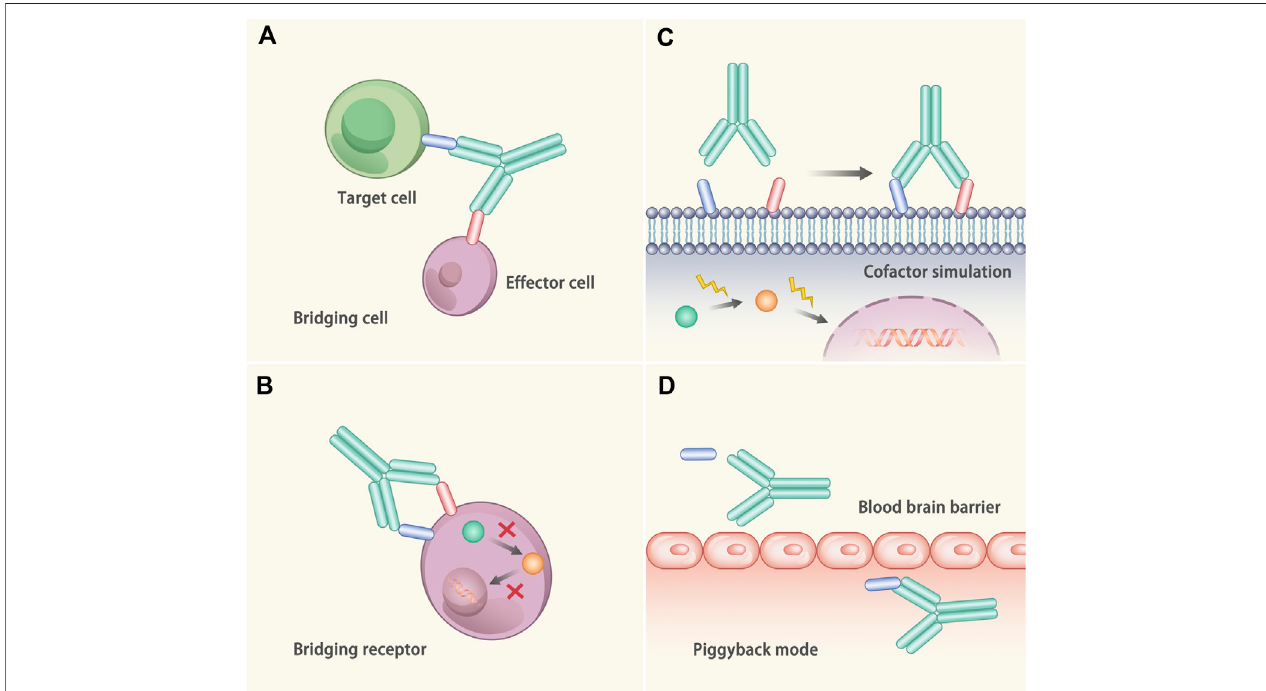
FIGURE 2 | Mechanisms of the bAb. (A) Bridging cell. The bAb binds to two different cells at the same time, thus dragging these two cells closer. (B) Bridging receptor. The bAb binds to two different proteins on the cell surface and plays a synergistic role, thus inactivating the target cell more ef fi ciently. (C) Cofactor simulation. ThebAbbindstotargetantigenandplaystheroleofagonisttotreatdiseases. (D) Piggybackmode.OneoftheantigenbindingpartsofthebAbcombineswiththetarget molecule, while the other antigen binding part of the bAb binds to the speci fi c area. In this way, the molecule is transported to the speci fi c area.